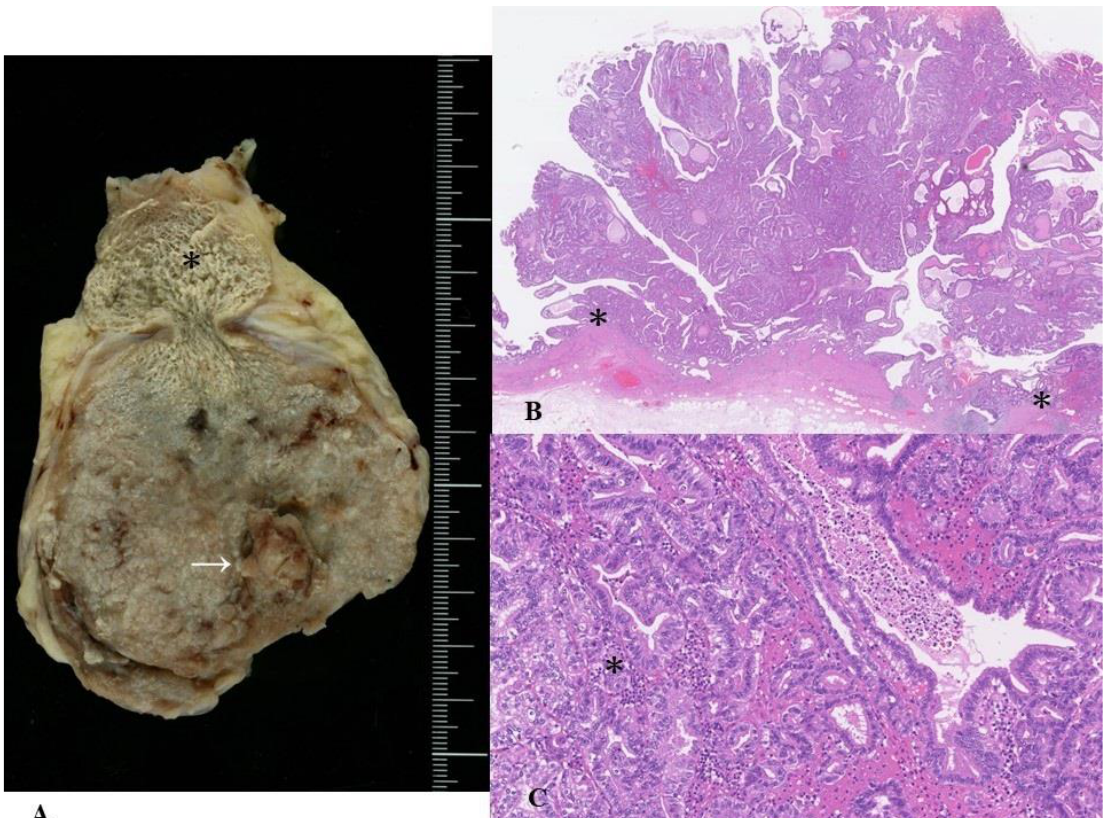
Figure 3. Intracholecystic papillary neoplasm of gallbladder. ( A ) Gross features. Polypoid or mass- forming lesion is seen in the fundus. In the surrounding mucosa showing rough appearance, small papillary or coarse granular lesions are multiply found. The mucosa of the neck is spared and shows cholesterosis (*). Conglomerated type. × 40. HE staining. ( B ) Conglom-erated papillary or polypoid neoplastic lesions with shorter papillary and flat neoplastic changes in the peripheral area (*). HE staining. ( C )High power magnification shows high-grade gastric differentiation, and some parts show low-grade differentiation or adenomatous features (*). High-grade dysplastic ICPN of gastric subtype. ×90. HE staining.